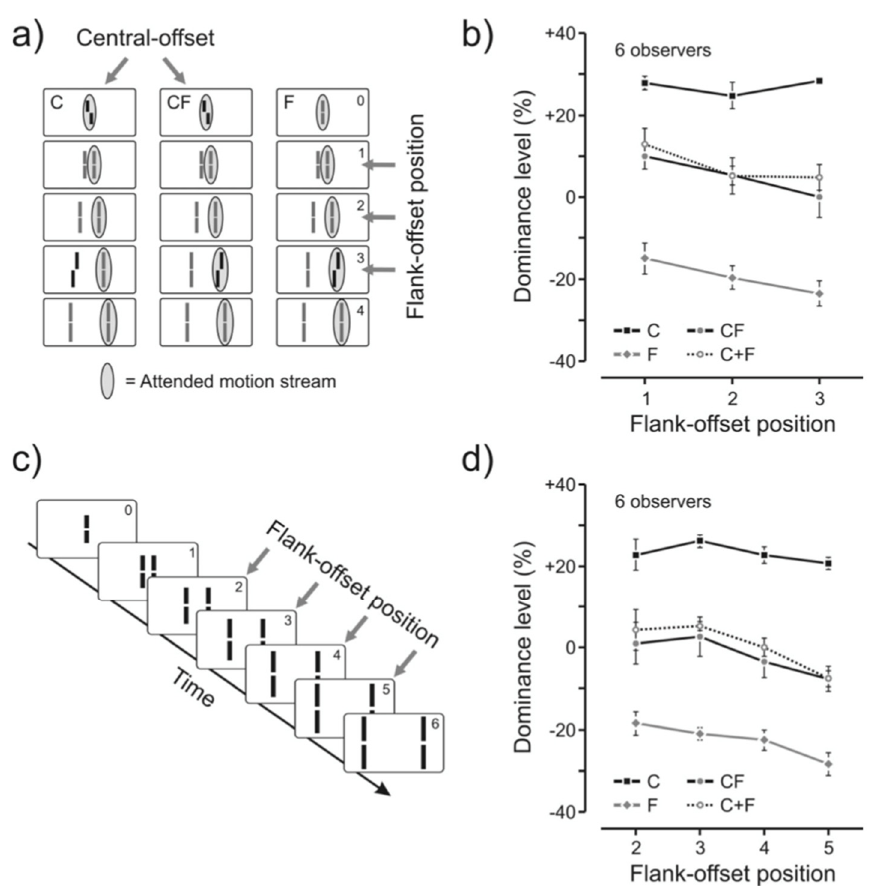
Figure 4. ( a ) Same paradigm as in the experiment before, with the exception that observers attended to the right stream. ( b ) A line (Flank) was offset in the opposite direction to the central vernier, which could be in the non-attended, left stream (condition C), in the attended, right stream (condition CF). In condition F, the central line was not offset. We varied the line/flank position for all conditions ( c ). ( b ) Dominance indicates to what extent the central offset determines the response. Values below indicate that line/flank offset dominates the response. If the flank offset is in the non-attended stream, dominance stays roughly constant because, as in the previous figure, it does not contribute to performance (condition C). If the central line is not offset, the line/flank offset determines performance the stronger the latter it comes (condition F). The effect is strongest for the last position. Combining conditions C and F (condition CF), leads to a dominance level, which is well described by a simple average of the two conditions (C + F). Hence, performance is roughly linear. ( d ) Same experiment as in ( b ) for the stimulus shown in panel ( c ) with flank-offset positions varying between 2 and 5. From Ref. [14].